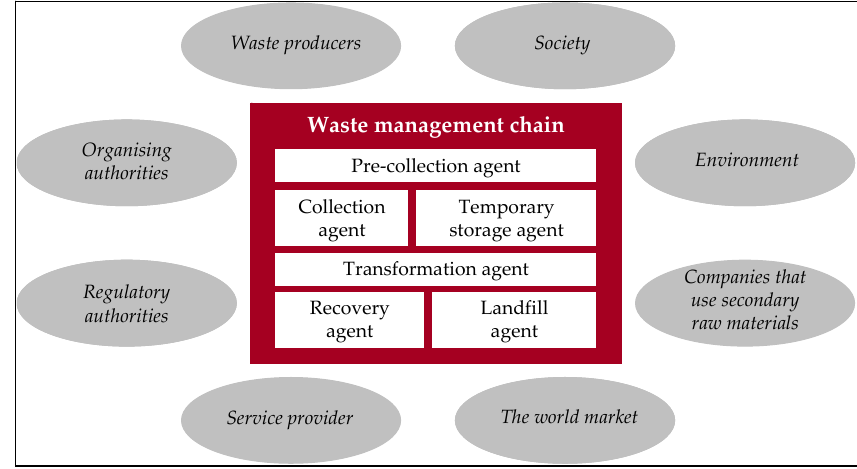
Figure 3 : Organization of subsystem of the waste management system, the « household waste 9 Fig. 3. Organisation of a subsystem of the waste management system, the “household waste management chain”. manegement chain » 10